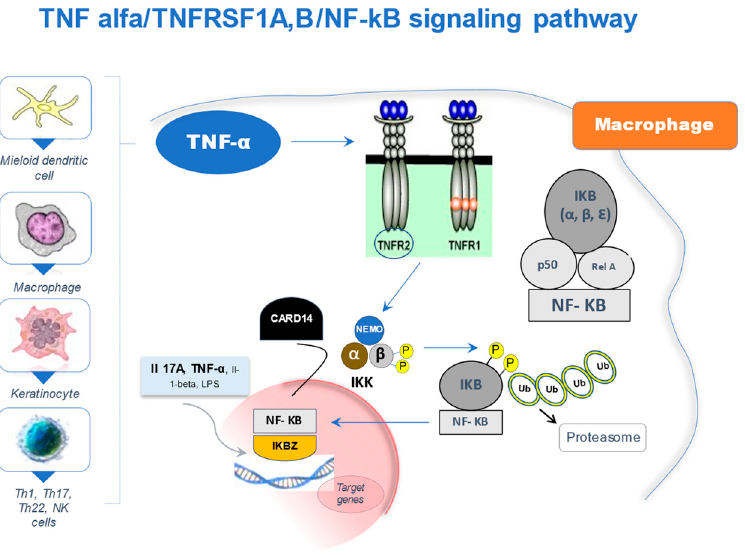
Figure 1. The TNF- α /TNFRSF1A,B/NF-KB signaling pathway. TNF- α is a pro-inflammatory cytokine synthesized by various cell lineages, mainly macrophages, dendritic cells, keratinocytes as well as various T cell types. It exerts its functions through binding to type 1 (TNFR1) and 2 (TNFR2) cell membrane receptors. TNFR2 (TNFRSF1B) shows higher affinity for TNF- α . NF- κ B is a dimer made up of Rel family proteins (p50, p52, Rel A/p65, cRel, and Rel B), the p50/p65 heterodimer being the most common. In the absence of TNF- α stimulation, the activity of NF- κ B is regulated at cytoplasmic level by an inhibitory complex of proteins called IKB or Kappa Beta inhibitors (IkB alpha, beta, and epsilon) that regulate its function by blocking its translocation to the nucleus. The binding of TNF- α to its receptors triggers the activation of the inhibitor kinases of NF- κ B or “IKK complex” consisting of IKK-alpha, IKK-beta and IKK-gamma or NEMO. The characteristic event is the phosphorylation of IKB-alpha by the IKKa/b complex, inducing its ubiquitination and degradation by the proteasome; and thus, allowing the release of NF- κ B. Once in the nucleus, NF- κ B meets another inhibitory protein called IKBZ. Likewise, IKBZ can act as a transcription factor regulated by IL-17A, IL-1beta, and to a lesser extent, by TNF- α . In turn, IKBZ plays an important role in the development and expansion of Th17 lineages. Finally, CARD14 activates NF- κ B by partially known mechanisms (see text for more details), although some authors suggest that CARD14 would activate the IKK complex, consequently regulating the activity of NF- κ B, leading to an increase in its transcriptional activity. TNF- α : tumor necrosis factor-alpha. TNFR1 (TNFRSF1A): TNF- α type 1 receptor. TNFR2 (TNFRSF1B): TNF- α type 2 receptor. NF- κ B: nuclear factor of kappa light chain enhancer of activated B cells. IKB: kappa-beta inhibitors. IKK: inhibitor kinases of NF- κ B. IKBZ: z-inhibitor protein of NF- κ B. IL: interleukin. Th: T-helper. CARD14: caspase recruitment domain family member 14.